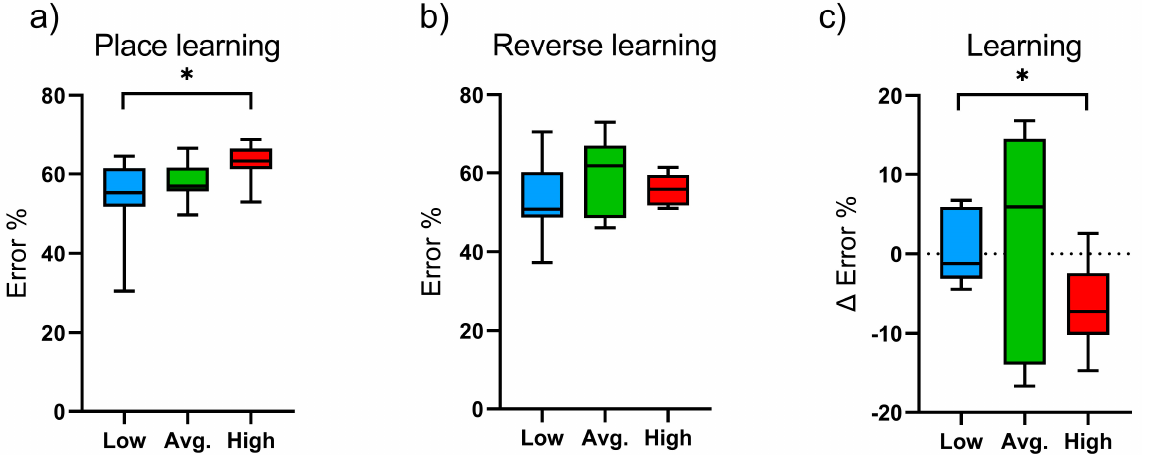
Figure 2. Learning of the running wheel groups (Low; n = 7, Avg.; n = 8, High; n = 7) in the IntelliCage. Error percentages in the ( a ) place learning and ( b ) reverse learning trials and the ( c ) relative learning. Statistically significant differences are indicated with an asterisk: * p < 0.1. Data are presented as mean and standard deviation.